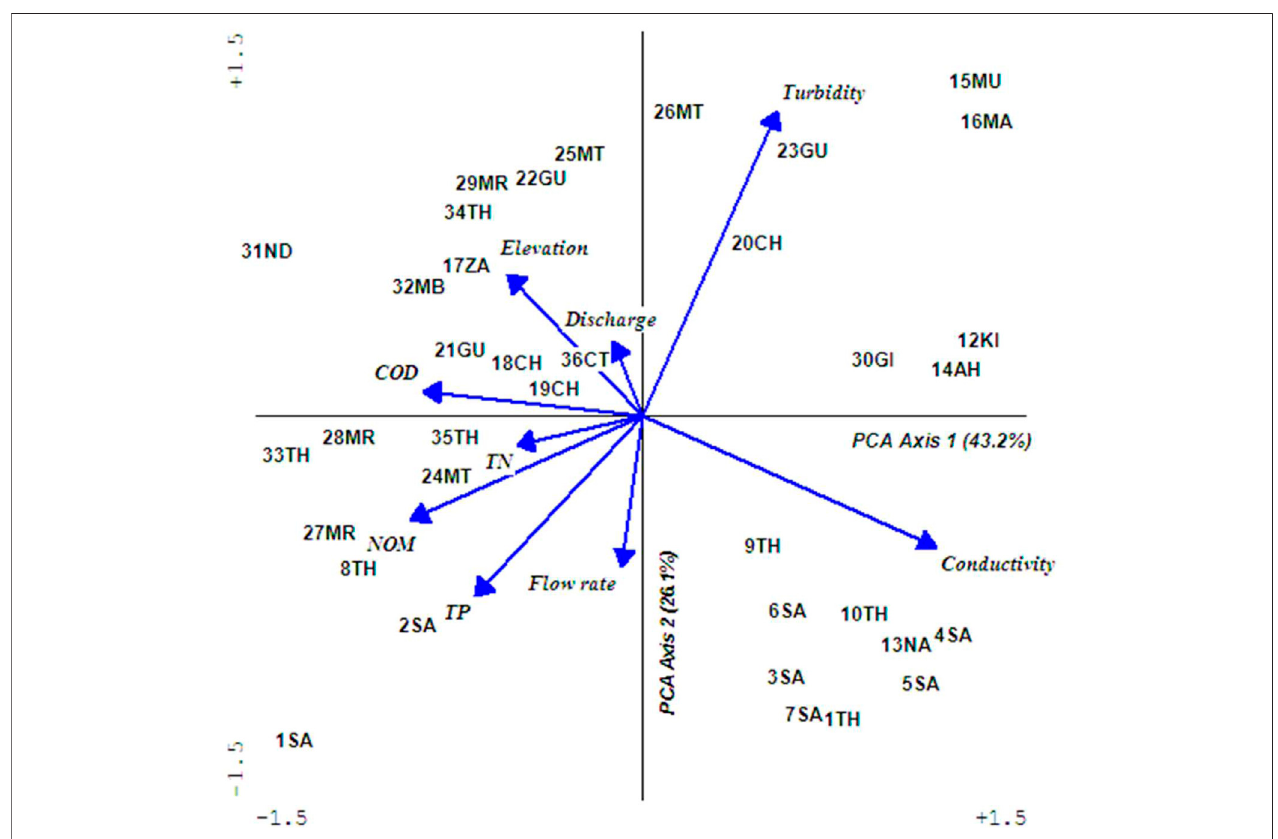
FIGURE3| APCAbiplotshowingthegroupingofsamplingsitesaccordingtowaterconditions.AbbreviatedlabelsrepresentTP:totalphosphates(mg/L),TN:total nitrogen (mg/L), COD: chemical oxygen demand (mg/L), and NOM: natural organic matter (mg/L). Units used to measure conductivity were (mS/cm), fl ow rate (m/ sec), and discharge (m 3 /sec). The full names of abbreviated sampling sites is given in Table 1 and original water quality is provided as Supplementary Table S1 .